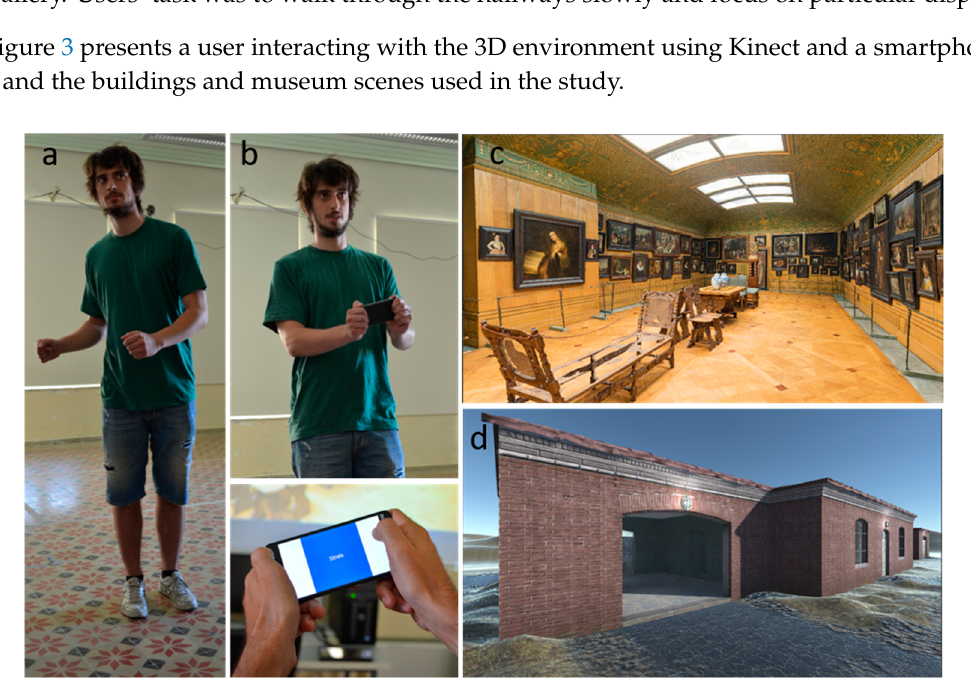
Figure 3. A user interacting with the 3D environment using Kinect ( a ) and a smartphone ( b ) and the two scenes used in the study: museum ( c ) and buildings ( d ). two scenes used in the study: museum ( c ) and buildings ( d